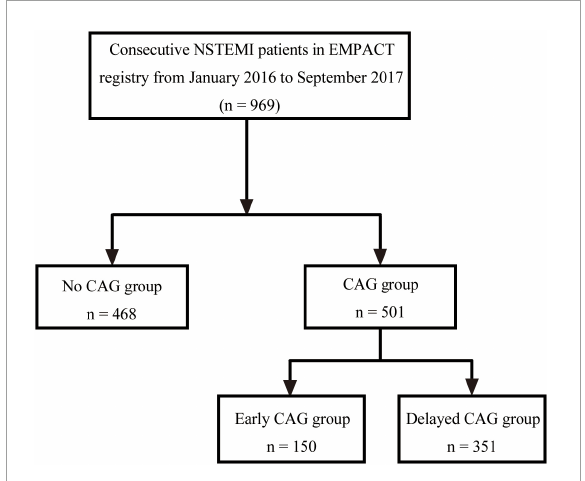
FIGURE1 Flow diagram of patient selection. AMI, acute myocardial infarction; STEMI, ST-segment elevation myocardial infarction; UA, unstable angina; NSTEMI, non-ST segment elevation myocardial infarction; CAG, coronary